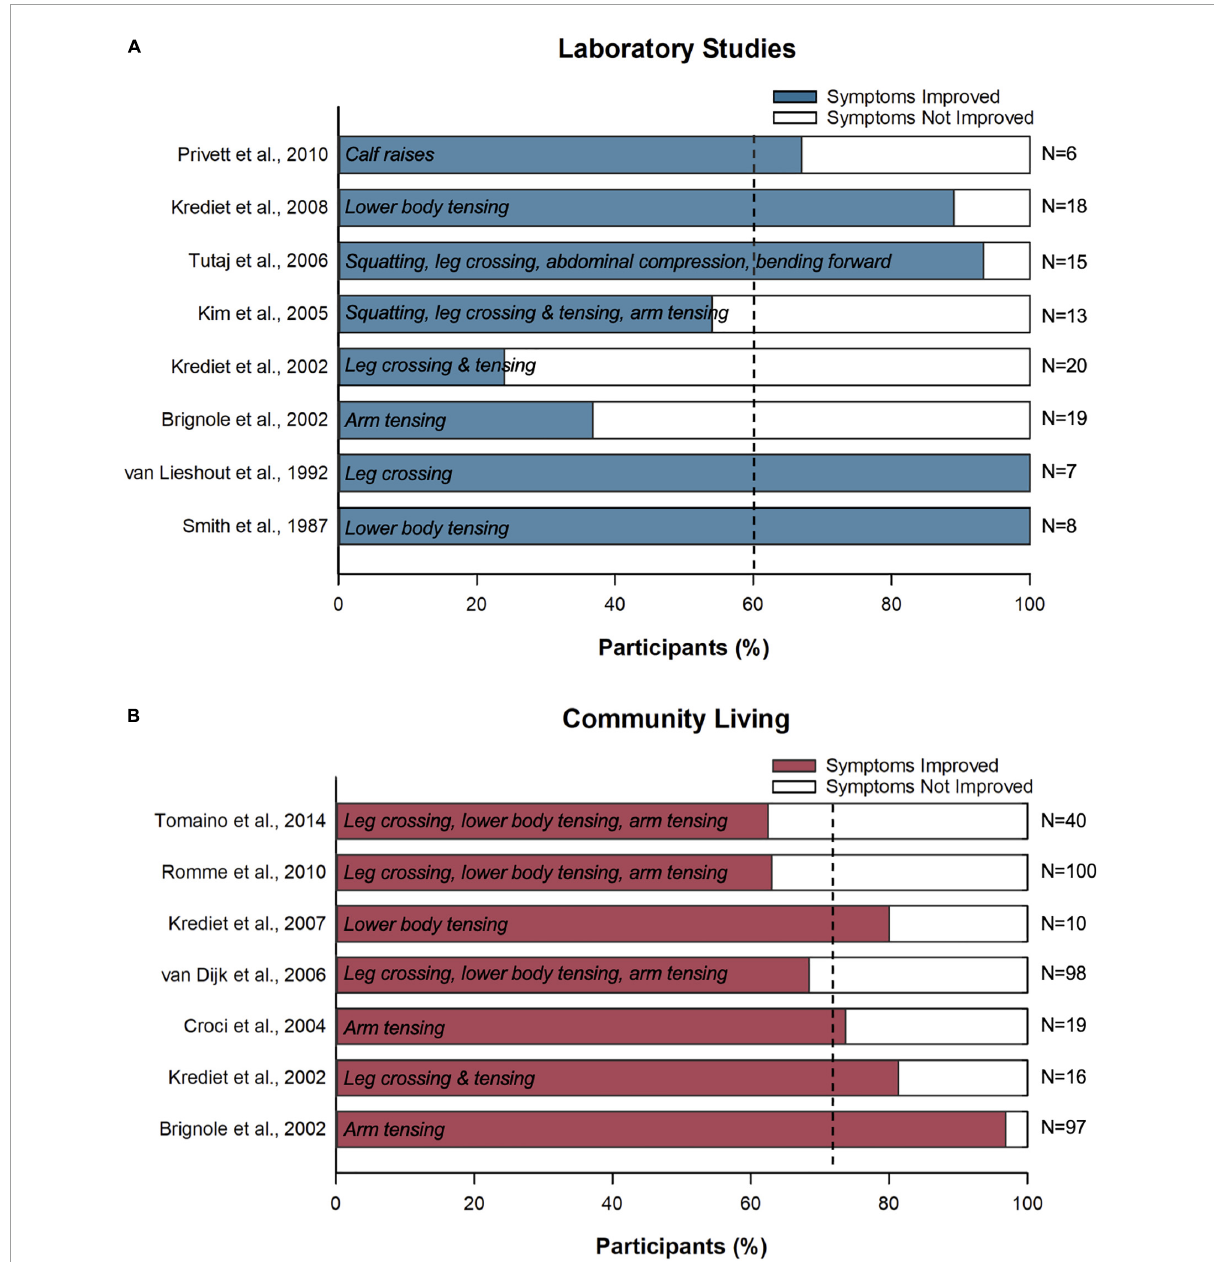
FIGURE5 Effects of counter pressure maneuvers on symptoms of syncope and presyncope. Bars show the proportion of patients (%) who reported recovered symptoms following counter pressure maneuver implementation in (A) the laboratory and (B) the community setting. White text indicates the counter pressure maneuvers investigated in each study. Vertical dotted lines indicate the pooled